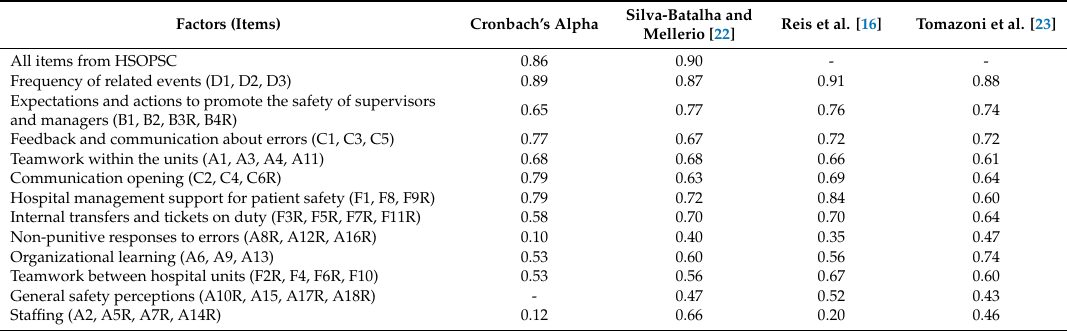
Table 3. Reliability Analysis (Cronbach’s α ) of Patient Safety Dimensions, in the Psychosocial Care Network of the Municipality of Rio Branco, according to the Questionnaire on Hospital’s Patient Safety Culture (HSOPSC),